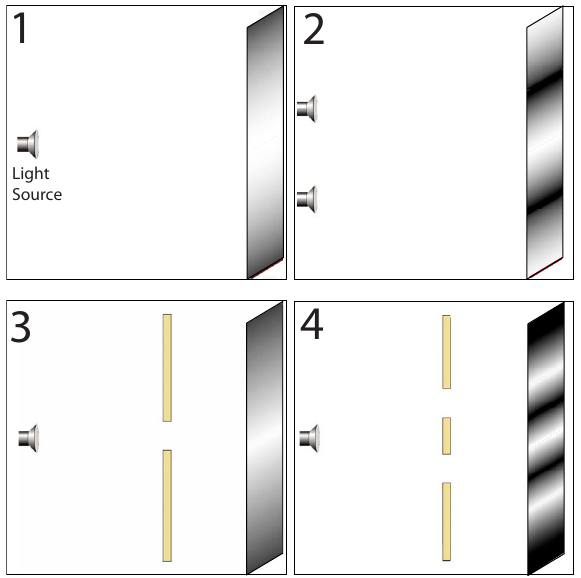
FIG. 4. (cid:1) Color (cid:2) Image of four “contrasting cases” used with open conceptual question for final two